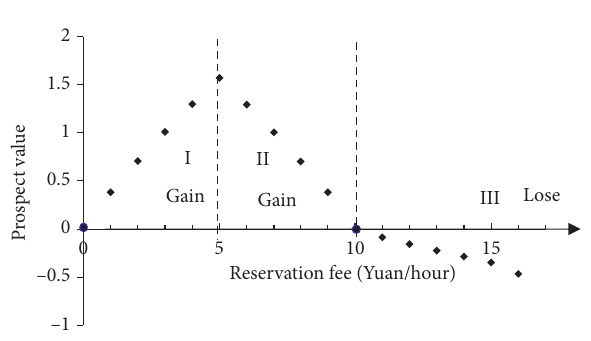
Figure 12: The prospect value under different choices of parking reservation fee (partial view).